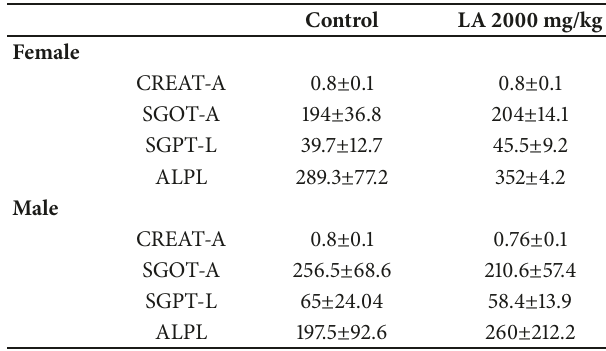
Table 5: Relative organ weight (g/100 g of body weight) of mice orally treated with L. angustifolia EO for 21 days.